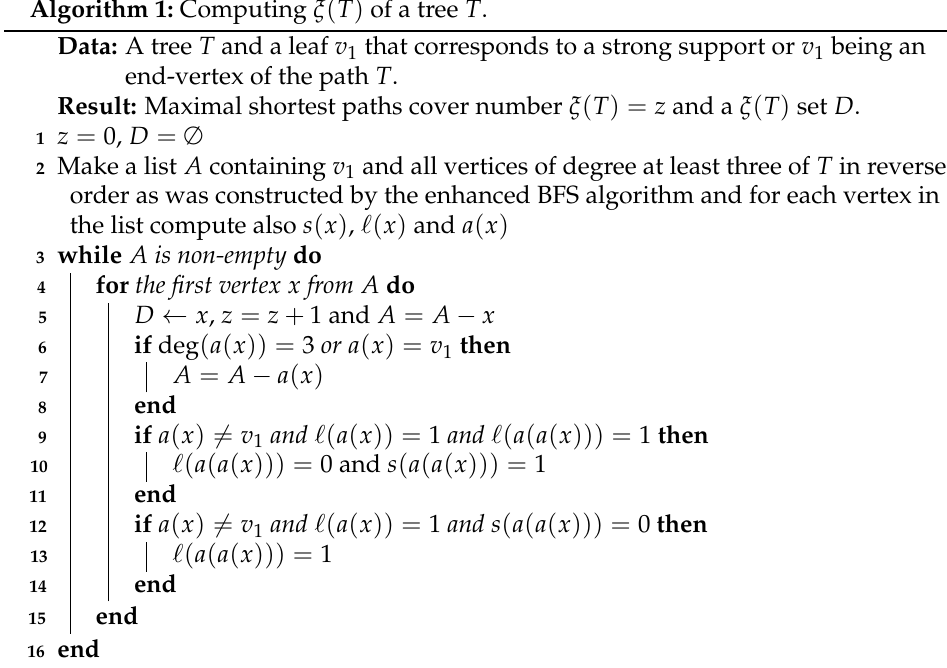
Algorithm 1: Computing ξ ( T ) of a tree T